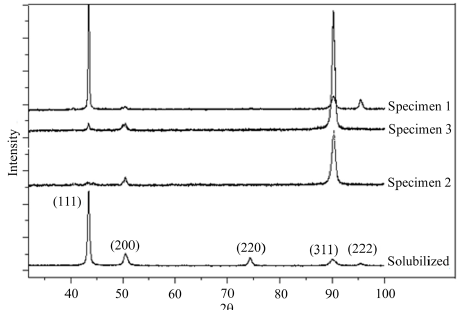
Figure 3. Values of the hardness (HV) and area reductions (RA) on superaustenitic stainless steel.